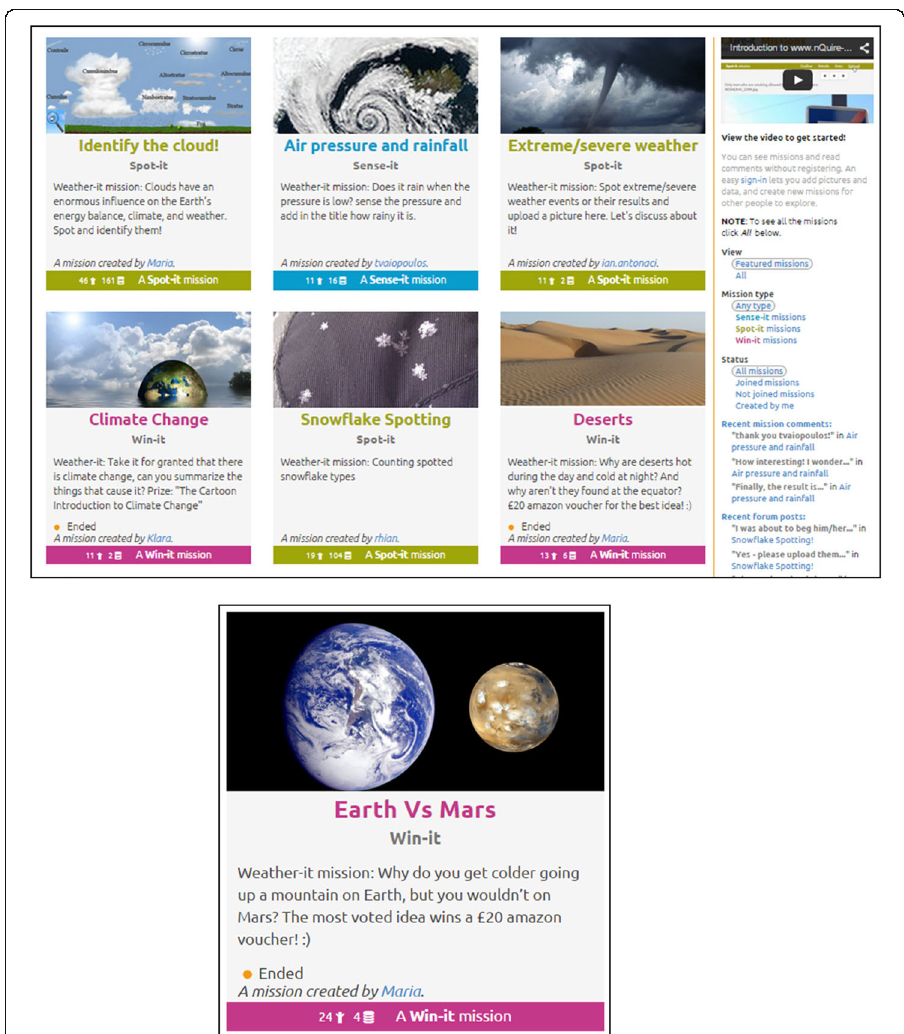
Fig. 4 The three types of missions on the nQuire-it platform: Spot-it missions in green, Win-it missions in pink, and Sense-it missions in light